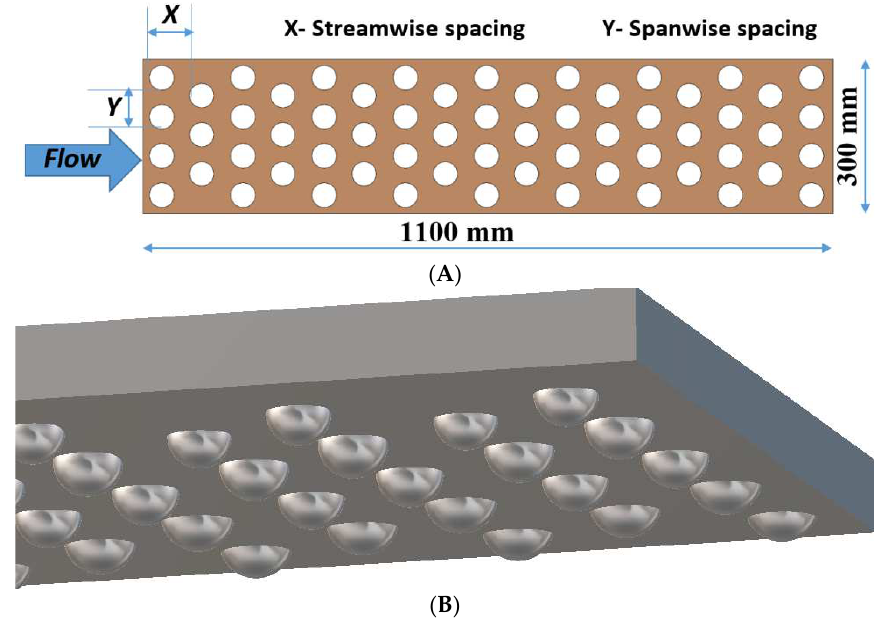
Figure 1. ( A ) Jet position on plate and ( B ) test plate with staggered protrusions.